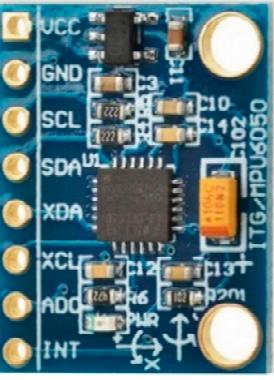
Figure 8. The ADXL335 3-axis ACC with a three-output analog pin x, y, and z [19–21]. As discussed above, the inertial measurement unit (IMU) works on six degrees of freedom (DoF). This sensor provides three directional acceleration and three directional orientation. In some applications, only the accelerometer is not enough to cope with motion-related tasks. Rather, the unaffected gravity gyroscope provides help to acquire the best motion-related results [20,35,38,83]. Therefore, the gyroscope and accelerometer are embedded into a single chip for the best and most efficient results, as shown in Figure 9 below. For the processing of tasks, a micro processing unit (MPU) is used. Among a variety of MPUs, the most famous is MPU 6050, which is available internationally at prices ranging from $25 to $30. The MPU 6050 is a six-DoF IMU device that operates on 3 V to 5 V with 400,000 Hz frequency using I2C communication. These data communication values are received with the help of 16 bit analogue-to-digital converter embedded into a micro controller unit (MCU).